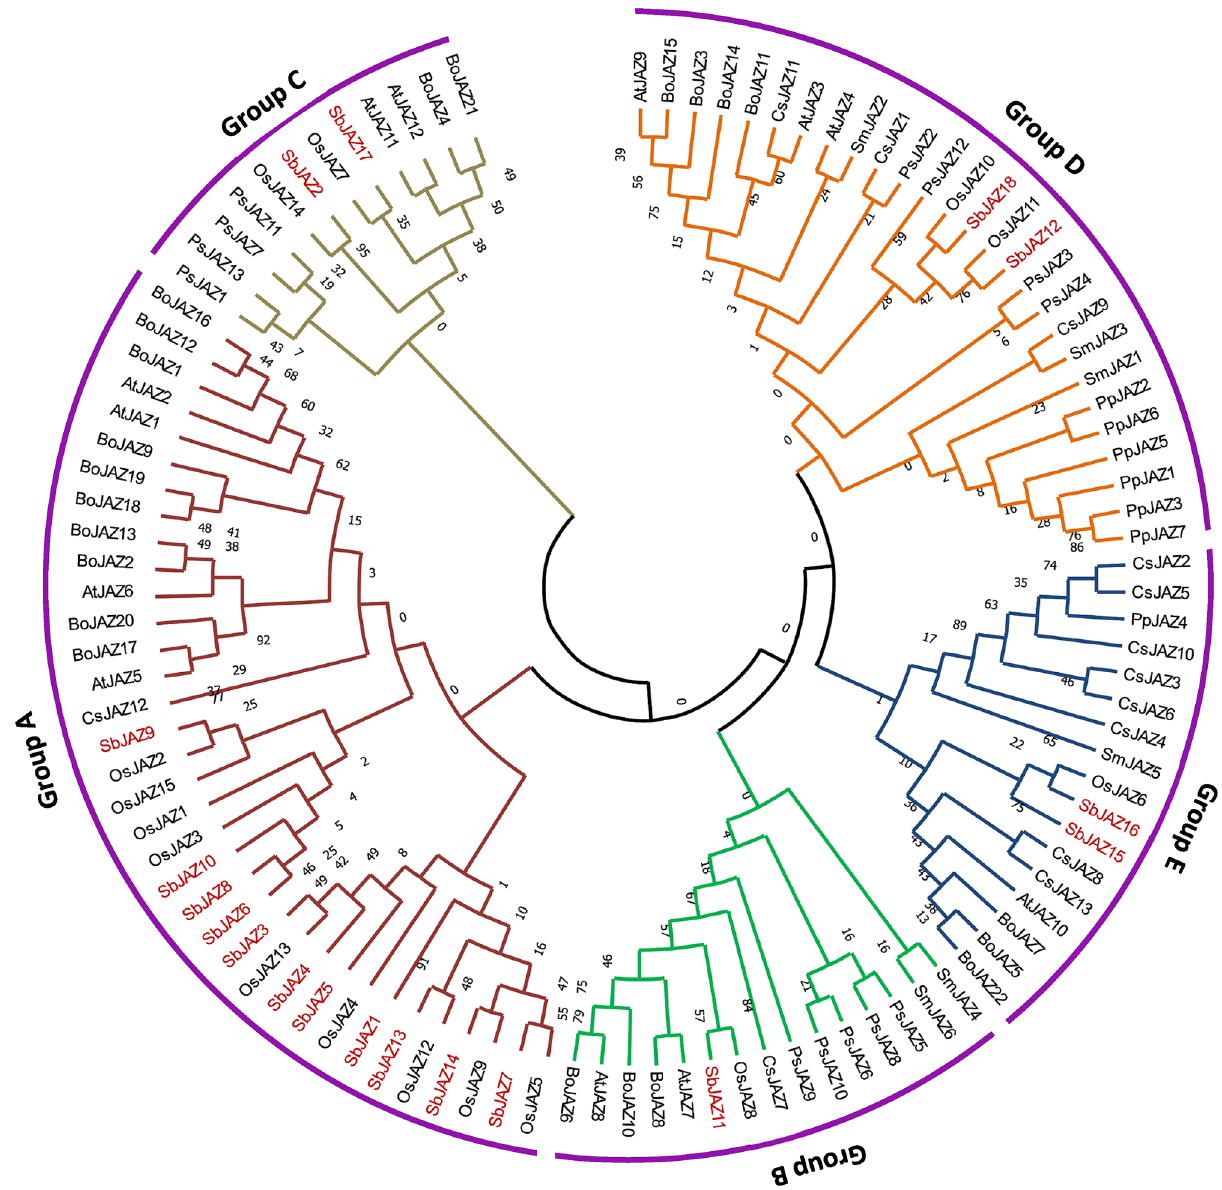
Figure 2. Phylogenetic analysis of the JAZ gene family. The circular tree represents the evolutionary relationship between the sorghum JAZ protein family with those in bryophyte, lycopodiophyte, gymnosperms, monocots and eudicots. The tree was generated by MEGAX using the Maximum Likelihood method based on the Poisson correction model using 1000 bootstrap values 40,41 . The analysis involved 106 amino acid sequences and they are divided into five classes. Species abbreviations used for phylogeny are as follows. At: Arabidopsis thaliana , Bo: Brassicae oleracea ; Cs: Camellia sinensis ; Os: Oryza sativa ; Pp: Physcomitrella patens ; Ps : Picea sitchensis; Sb: Sorghum bicolor and Sm: Selaginella